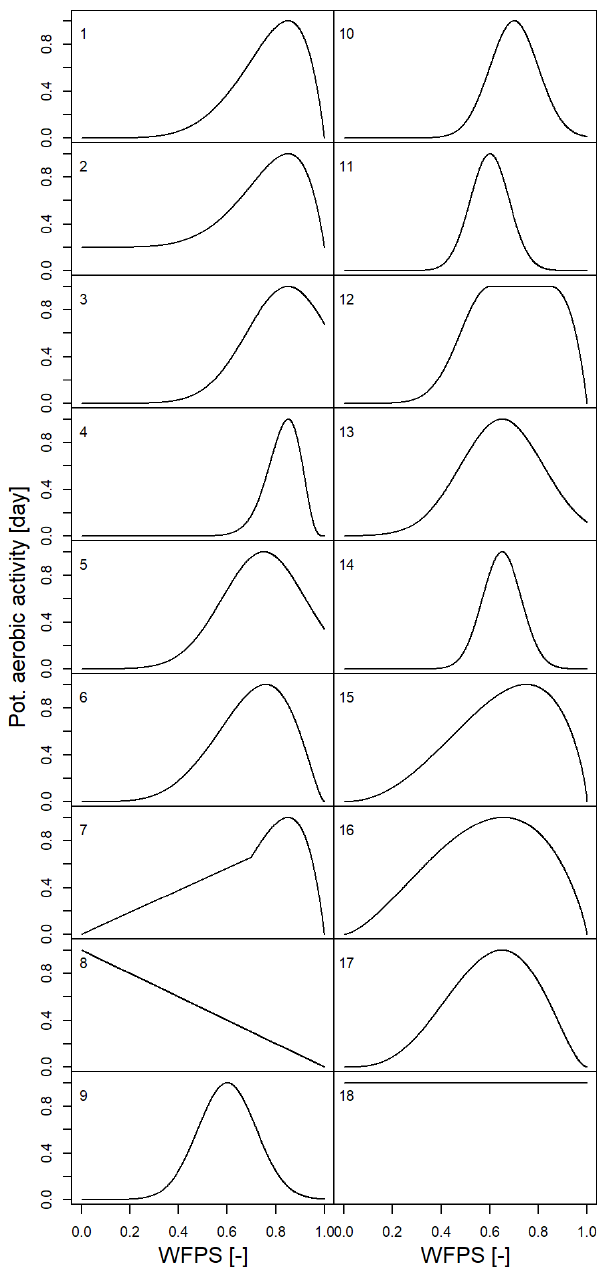
Figure 4. The ensemble of WFPS optimum curves that was tested during model